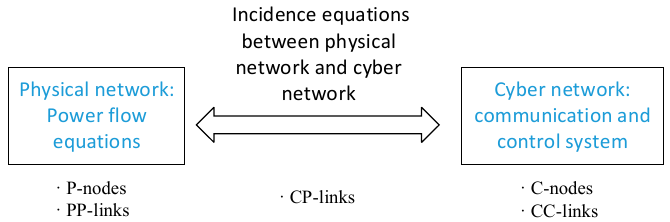
Figure 1. The node–link model in a Cyber-Physical Power System Figure 1. The node – link model in a Cyber-Physical Power System (CPPS).